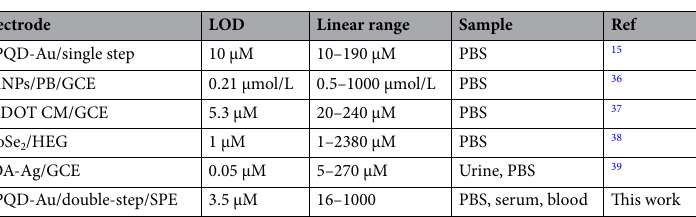
Table 3. Comparison of NADH detection based on an electrochemical reaction. PEDOT: poly(ethylene dioxythiophene), CM: colloidal microparticles, GCE: glassy carbon electrode, HEG: hydrogen-exfoliated graphene, ADH: alcohol dehydrogenase, POA: poly(o-anisidine), NPQD: 4 ′ -mercapto-N-phenylquinone diamine, SPE: screen-printed